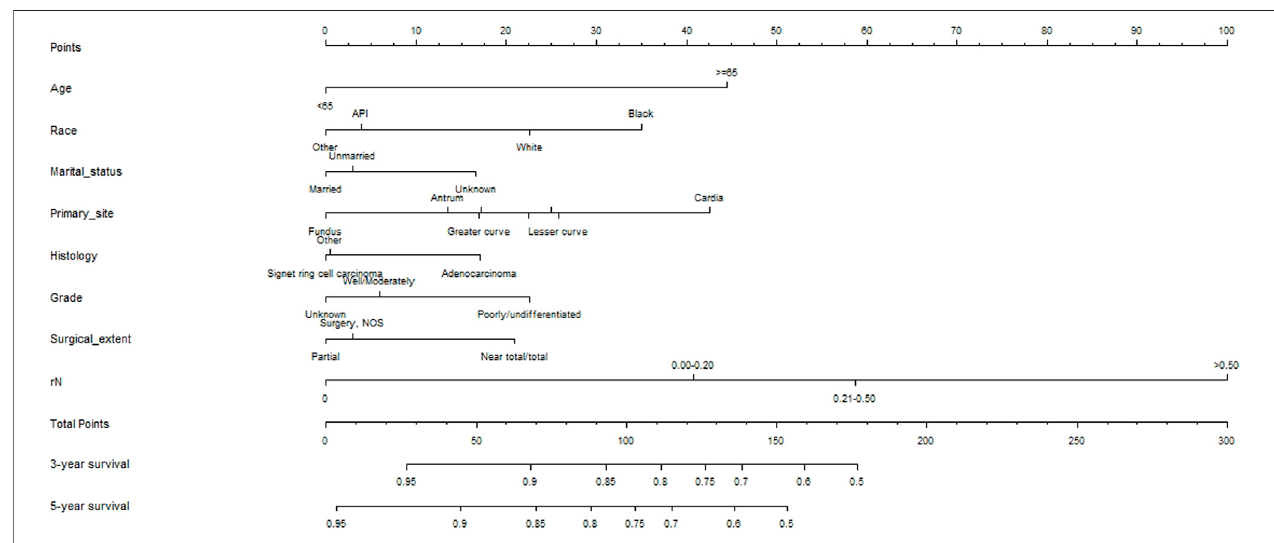
FIGURE 3 | Prognostic nomograms for patients with surgery on early gastric